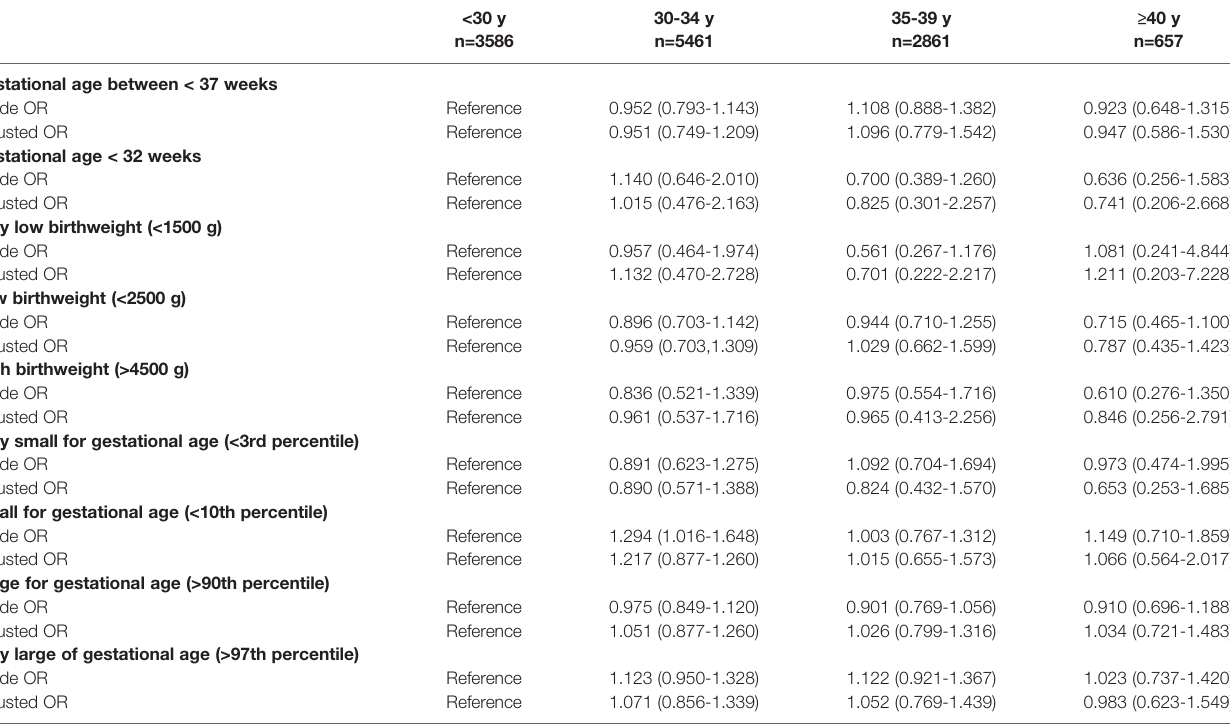
TABLE 3 | Odds ratios for gestational age and birth weights by maternal age.